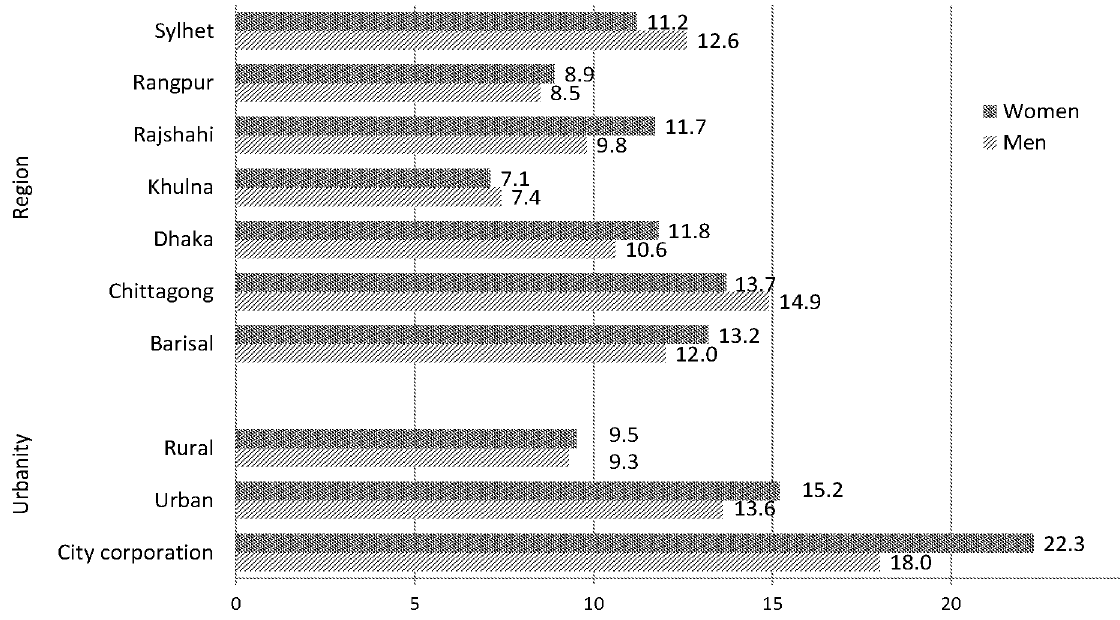
Figure 2. Prevalence of diabetes by urbanity and region of residence.